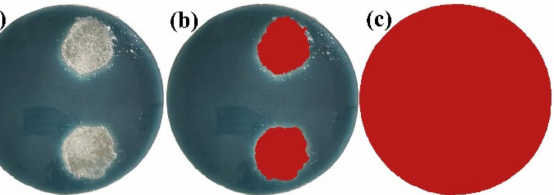
Figure 2. Diagram of slag surface of ladle (Top view). ( a ) Initial diagram; ( b ) pixel statistics of slag eye; ( c ) pixel statistics of slag